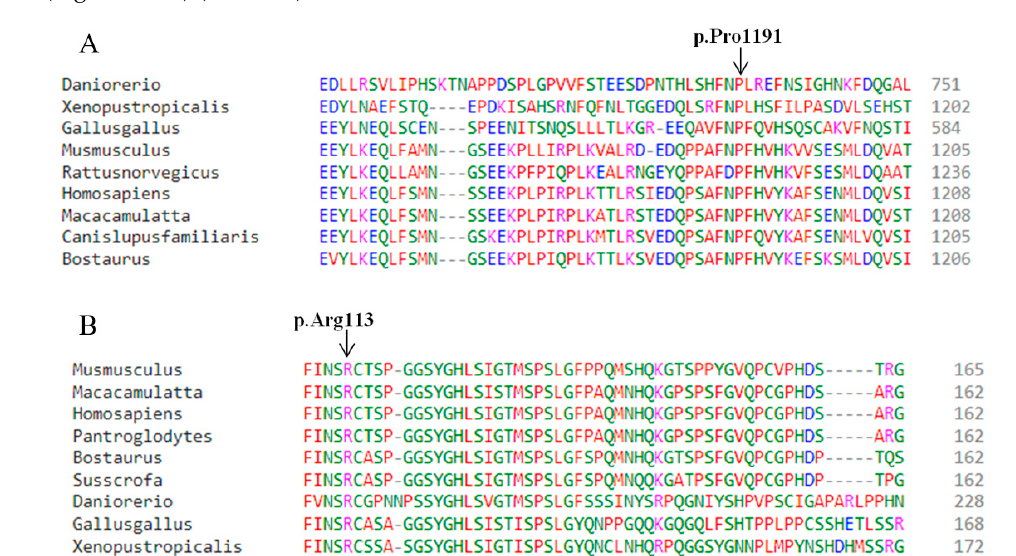
Figure 6. Interactions of wildtype and mutant KIAA0825 with close interactor C1orf167. ( A ) Four residues (chain A) of the wildtype KIAA0825 interacting with fi ve residues (chain B) of C1orf167 via three hydrogen bonds and two salt bridges. (B) Eight residues (chain A) of the mutant KI- AA0825 interacting with nine residues (chain B) of C1orf167 via 7 hydrogen bonds and two salt bridges.